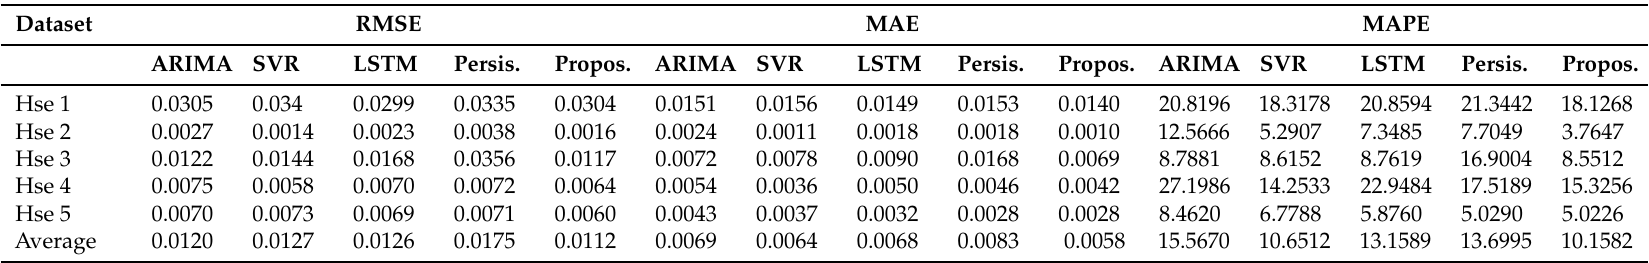
Table 1. Prediction results comparison between ARIMA, SVR, LSTM, persistent model (persis.) and the proposed method (propos.), using RMSE, MAE and MAPE.